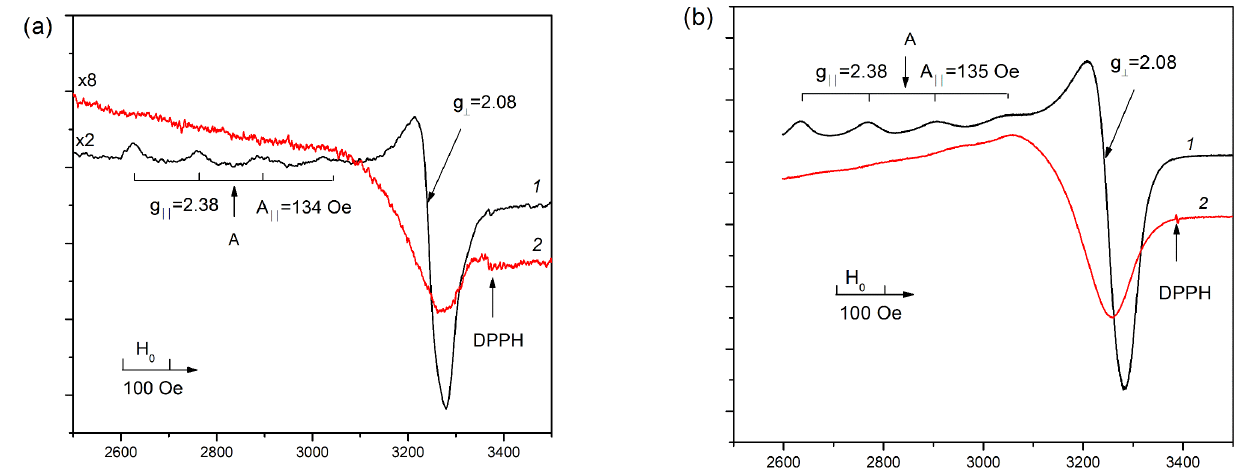
Figure 4. EPR spectra of the ion-exchanged Cu-containing MFI ( a ) and ZSM-5 ( b ) samples recorded at − 196 °C (1) and 25 °C (2). Copper loading is 1 wt.%. Table 3. The main electronic state of Cu-ions in Cu-containing zeolites prepared by different meth- ods and their UV-Vis DR and EPR characteristics.